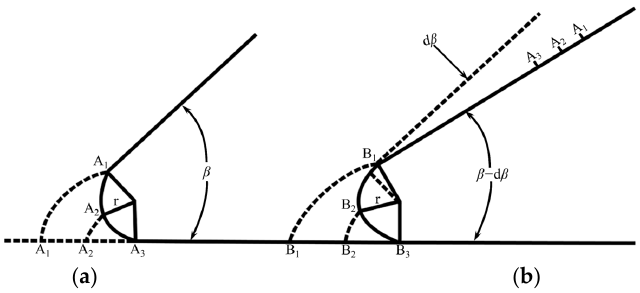
Figure A3. Basic folding element